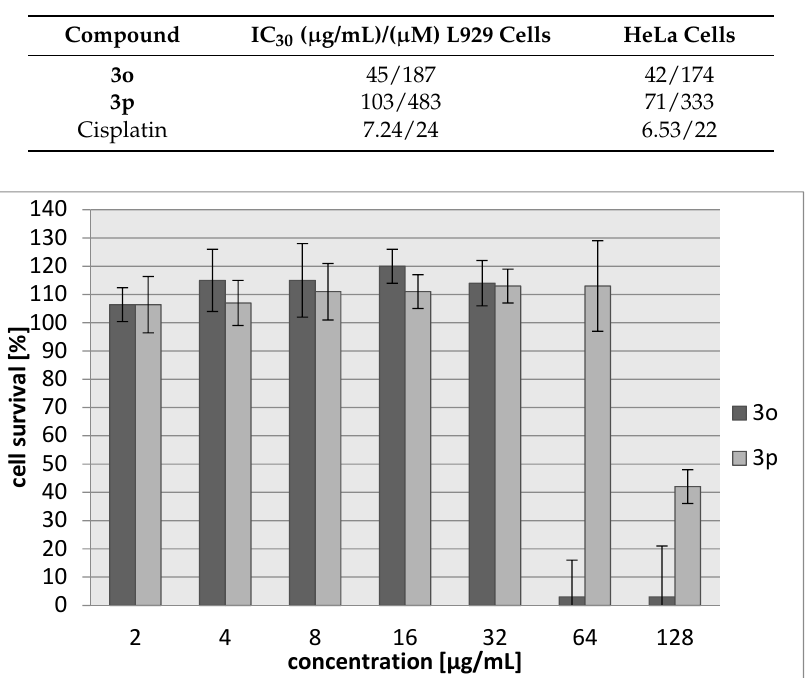
Figure 5. Concentration-dependent cytotoxic activity of 3o and 3p for L929 cell line.